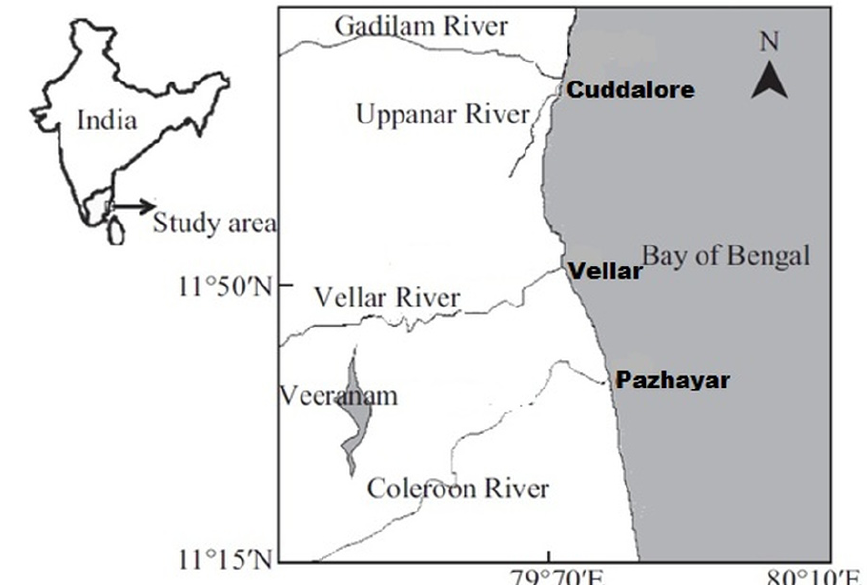
Fig. 1. Map showing the sample collection sites in Coromandel coast of